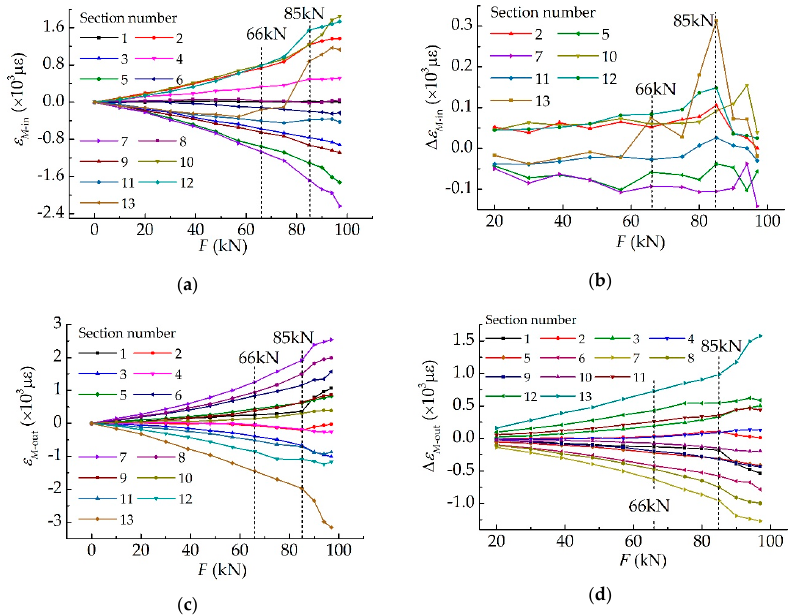
Figure 6. The stressing state submodes for bending moments: ( a ) ε M -in - F curves; ( b ) ∆ ε M -in - F curves; ( c ) ε M -out - F curves; ( d ) ∆ ε M -out - F curves.